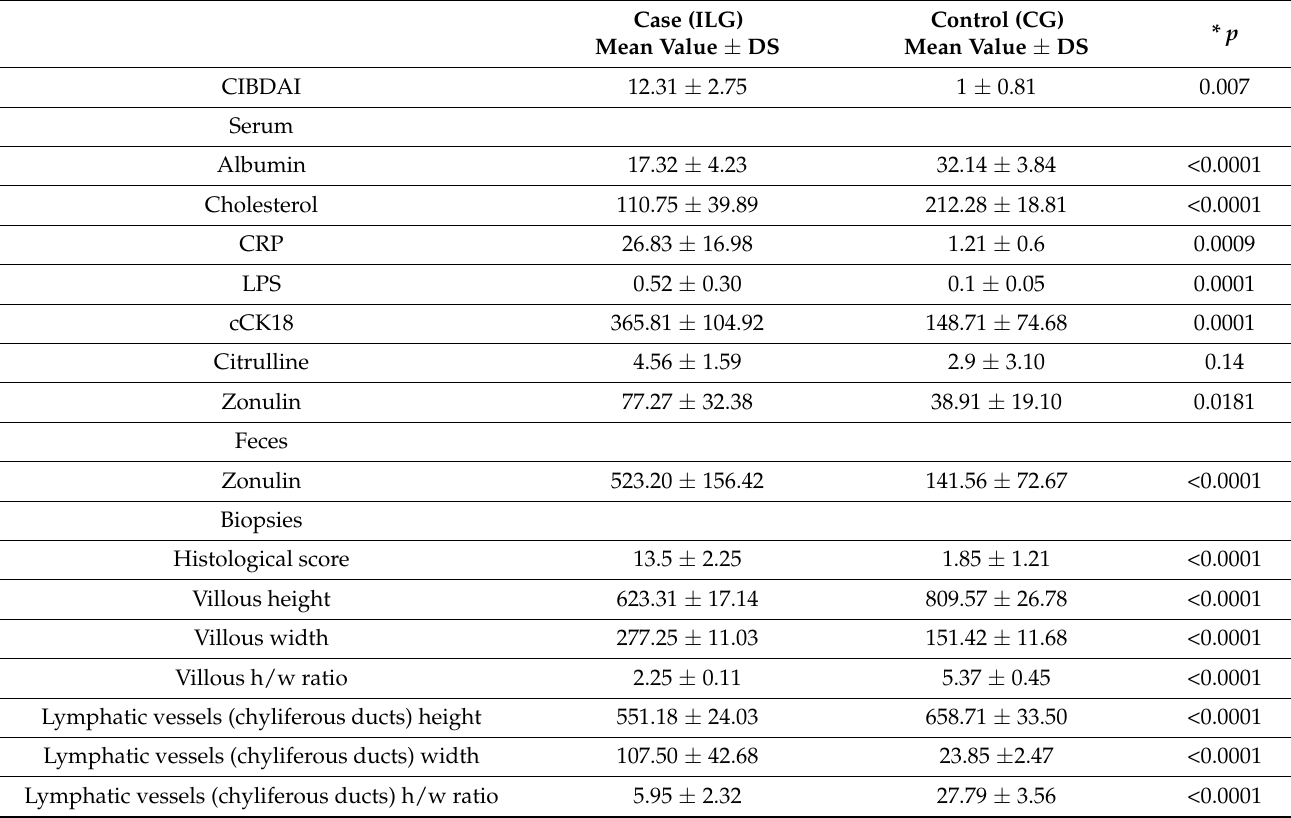
Table 1. Comparison between ILG and CG with regard to clinical score, intestinal markers, and histological evaluations.